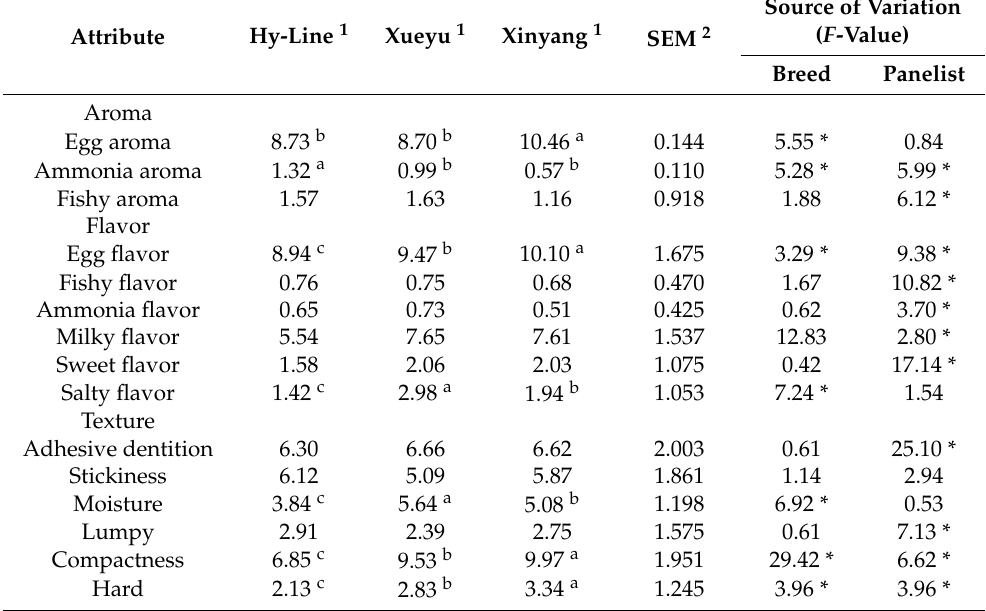
Table 3. Sensory attributes of egg yolks from Hy-Line, Xueyu, and Xinyang laying